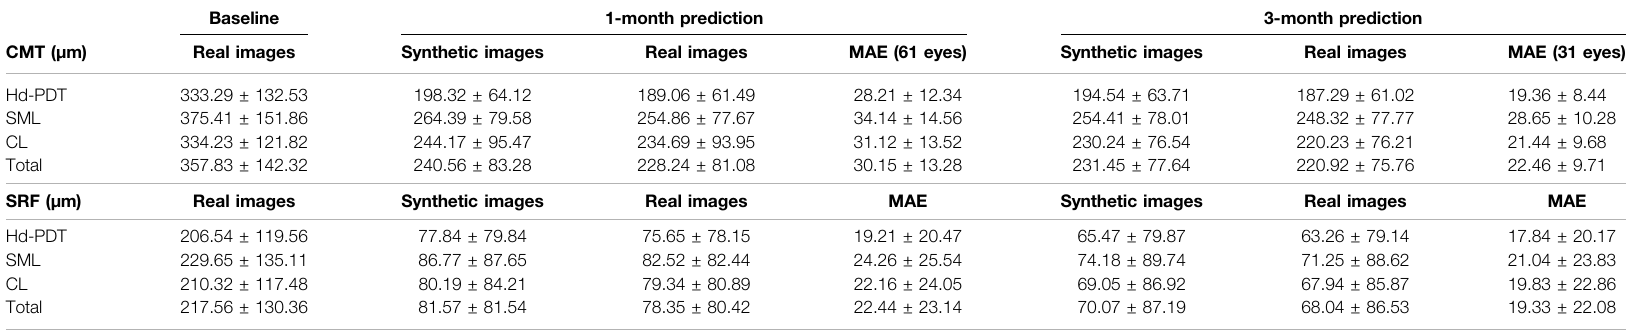
TABLE 3 | Accuracy of the synthetic post-therapeutic OCT images in determining the CMT and SRF in the evaluation